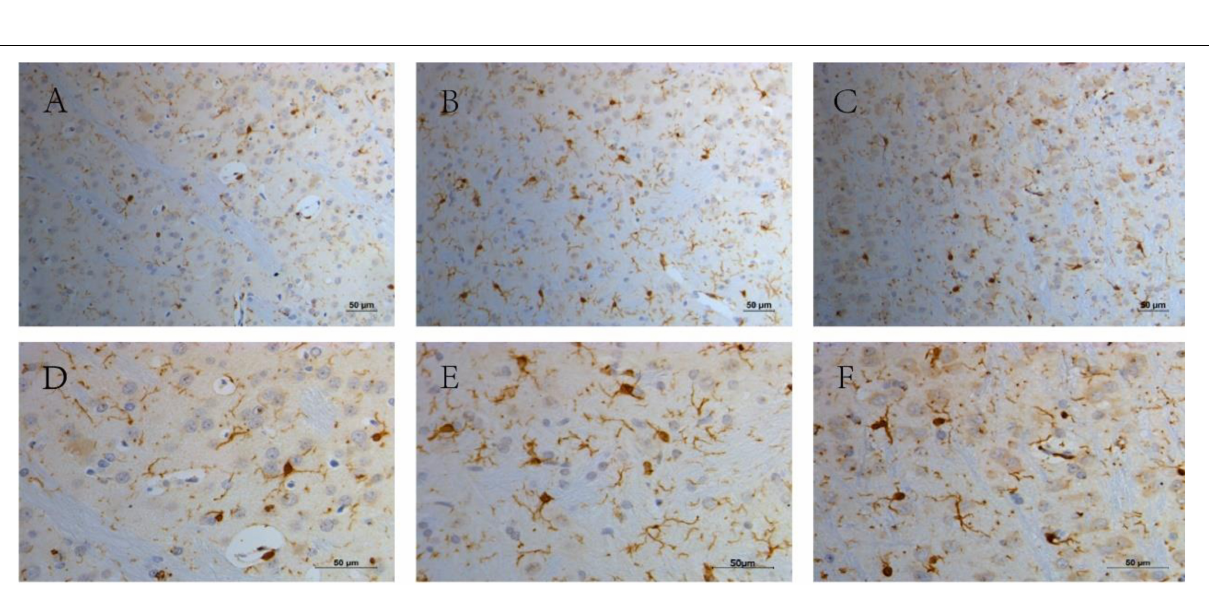
Frontiers in Behavioral Neuroscience |